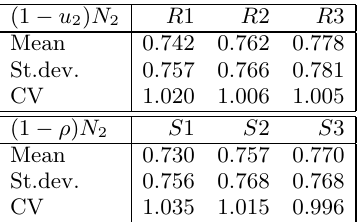
Table 2: Simulated means, standard deviations, and coefficients of variation of(1 − u 2 ) N 2 for Example 2.